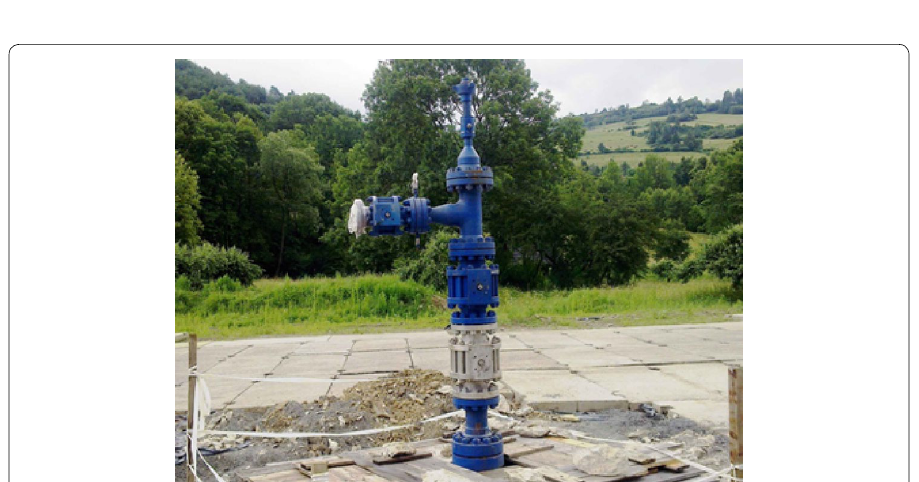
Fig. 13 New wellhead of the Poręba Wielka IG-1 well (photo: B.